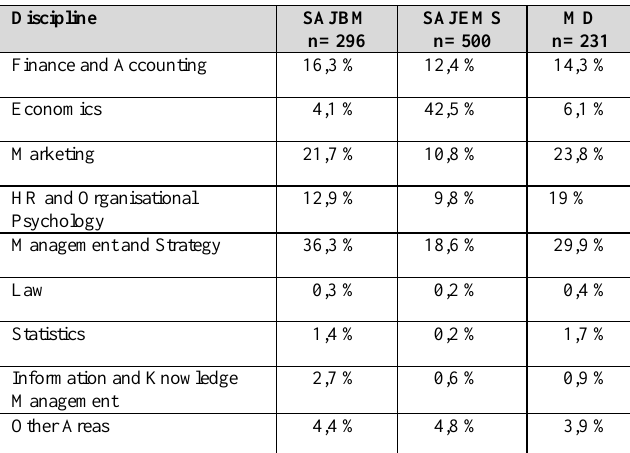
Table 7: Research design and methodology of articles over all three